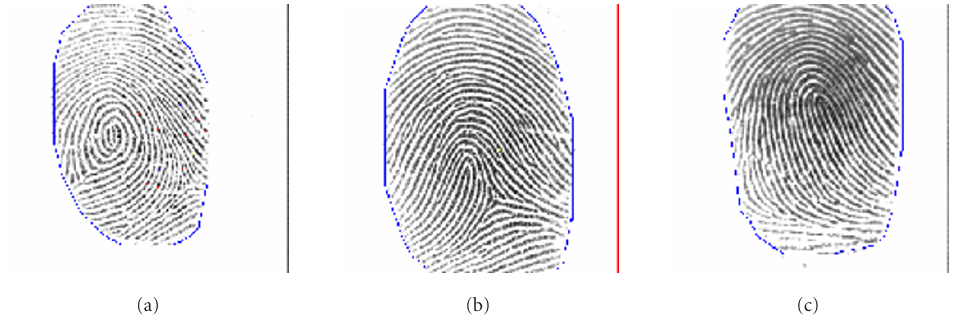
Figure 24: Segmentation results of three fingerprints from FVC2002 DB1: (a) is from the training data, (b) and (c) are from the test data.